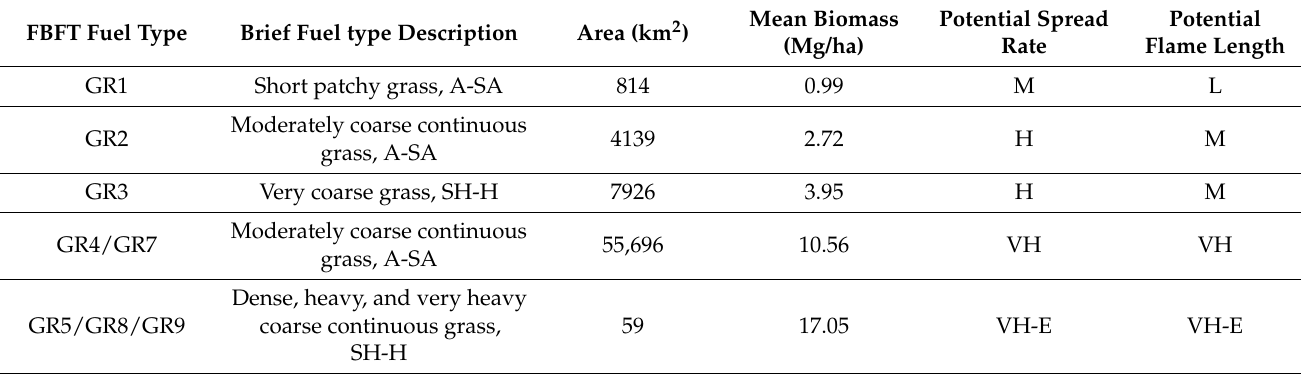
Figure 7. FBFT-adapted fuel map for the Iberian Peninsula and the Balearic Islands (2020 – 2021). Table 2. Characterization and parameterization of the FBFT-adapted grass fuel types. The values refer to mean fuel conditions and serve to predict fire behaviour inside and outside the fire season.